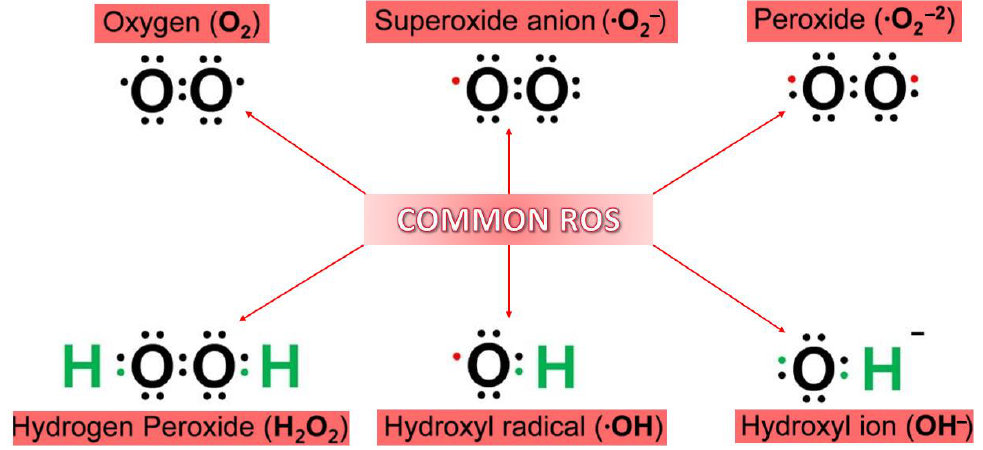
Figure 1. Generally known reactive oxygen species (ROS). Adapted from [13].